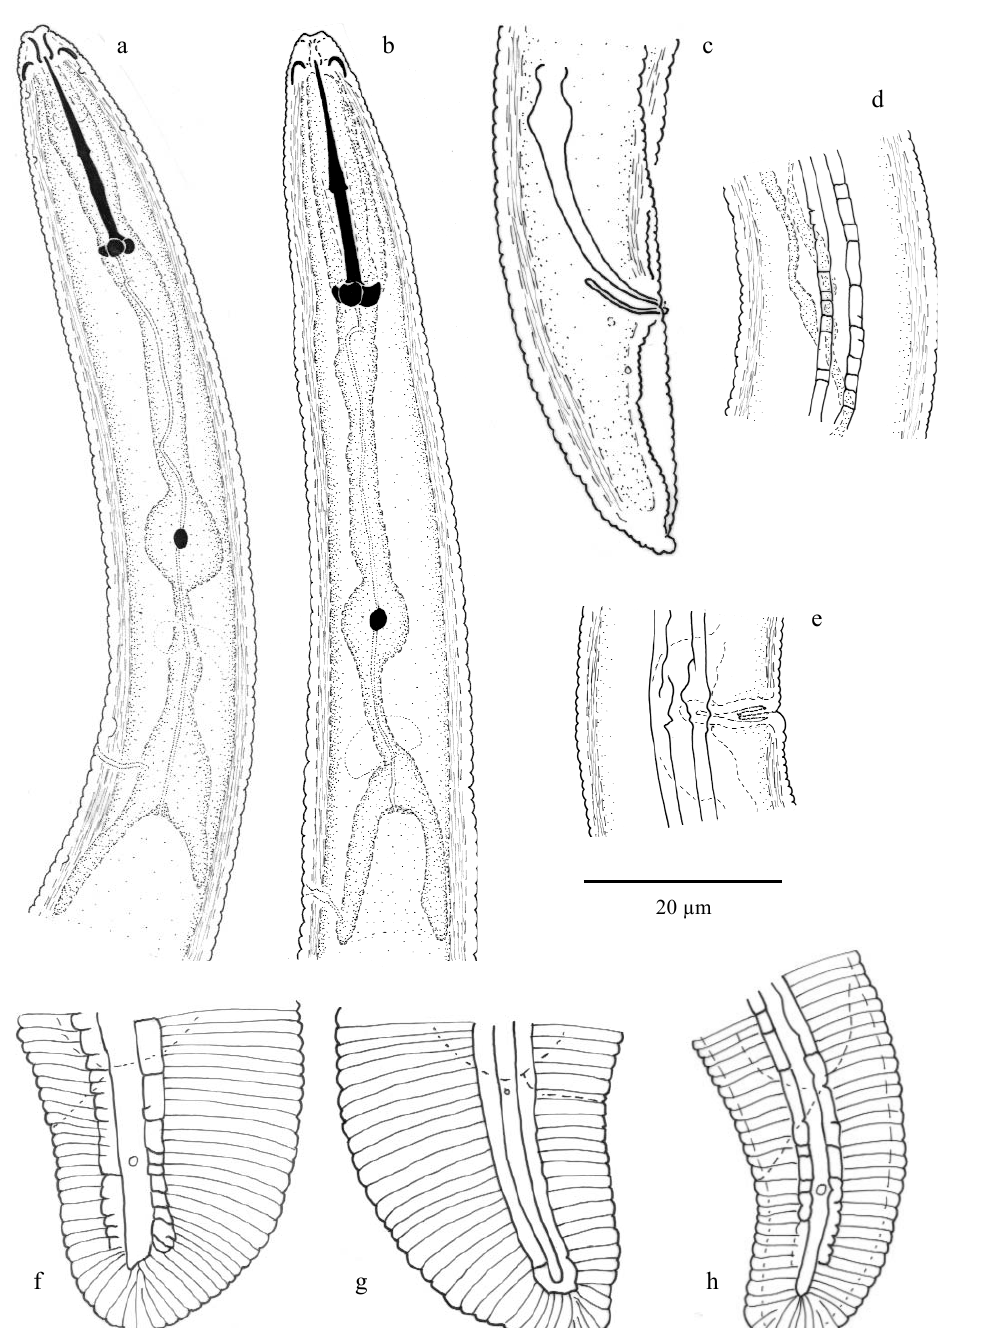
Fig. 2. Helictylenchus curatus sp. n. Female. (a) Oesophageal region. (d) Lateral field and fasciculi. (e) Vul- val region. (f-h) Posterior part of body. Male. (b) Oesophageal region. (c) Posterior part of